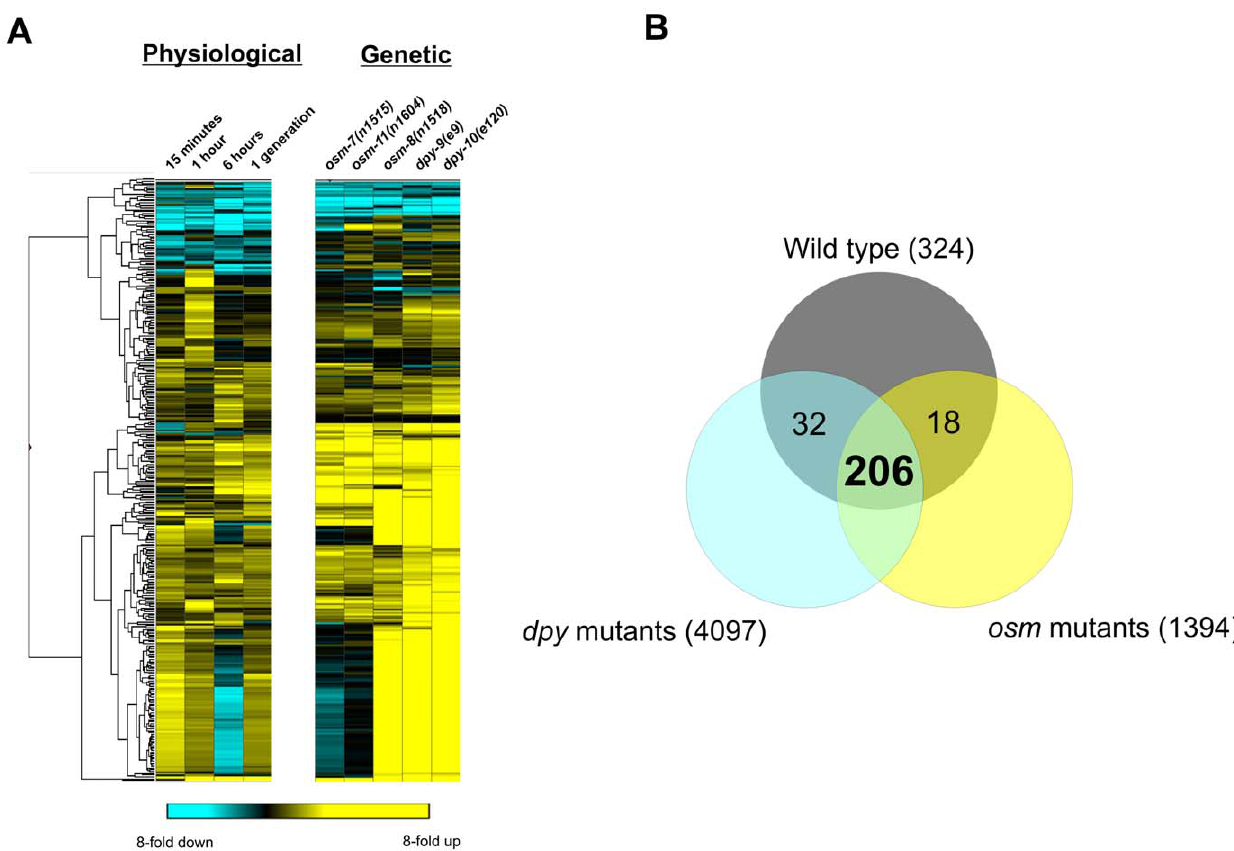
Figure 1. Expression profiling of the hypertonic stress response in C.elegans . (A) Hierarchical clustered heat map of gene expression changes associated with physiological activation of osmosensitive gene expression (200 mM NaCl for the indicated time interval) and the regulation of those genes in various osr mutants under normal conditions (50 mM NaCl). For filtering and statistical criteria, see ‘Methods’. (B) Venn diagram showing the overlap between genes differentially regulated by osmotic stress, osm mutants, and dpy mutants.